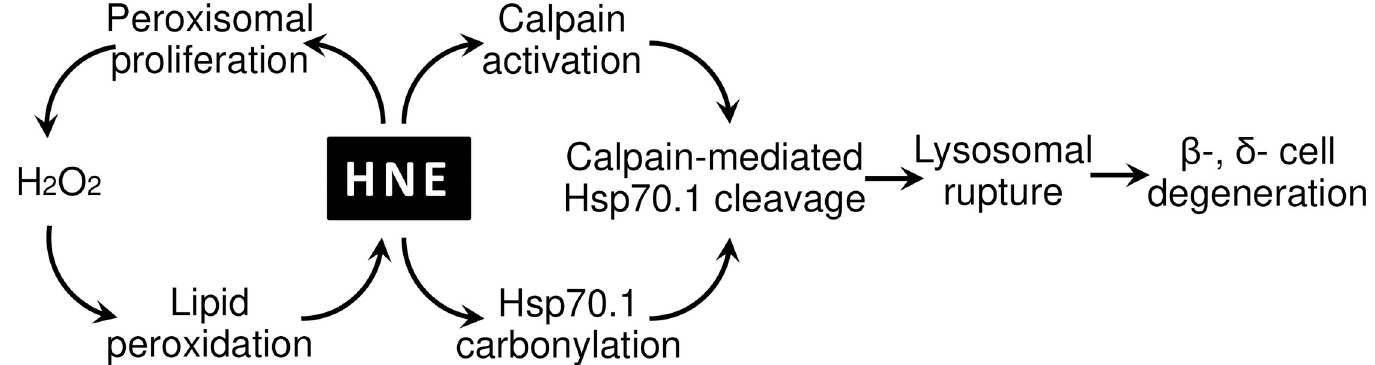
Fig 8. The molecular cascade explaining degeneration of β - and δ - cells in the Langerhans islet of the monkey after hydroxynonenal injections. Peroxisomes play a crucial role for the sustained H 2 O 2 production, while calpain-mediated cleavage of carbonylated Hsp70.1 causes lysosomal membrane rupture/permeabilization. In both cascades, hydroxynonenal plays a central role for the β - and δ - cell degeneration.